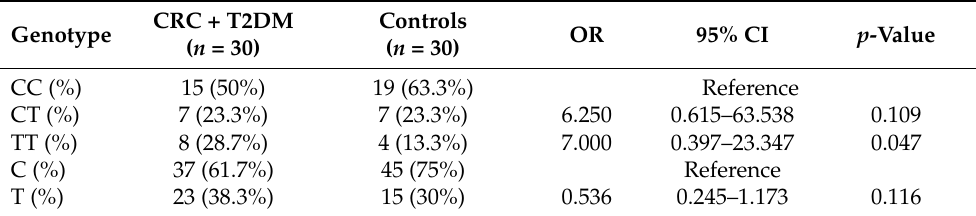
Table 7. Genotype and allele distribution and analysis of the association of rs16969681 of GREM1 in subjects with CRC + T2DM and controls.